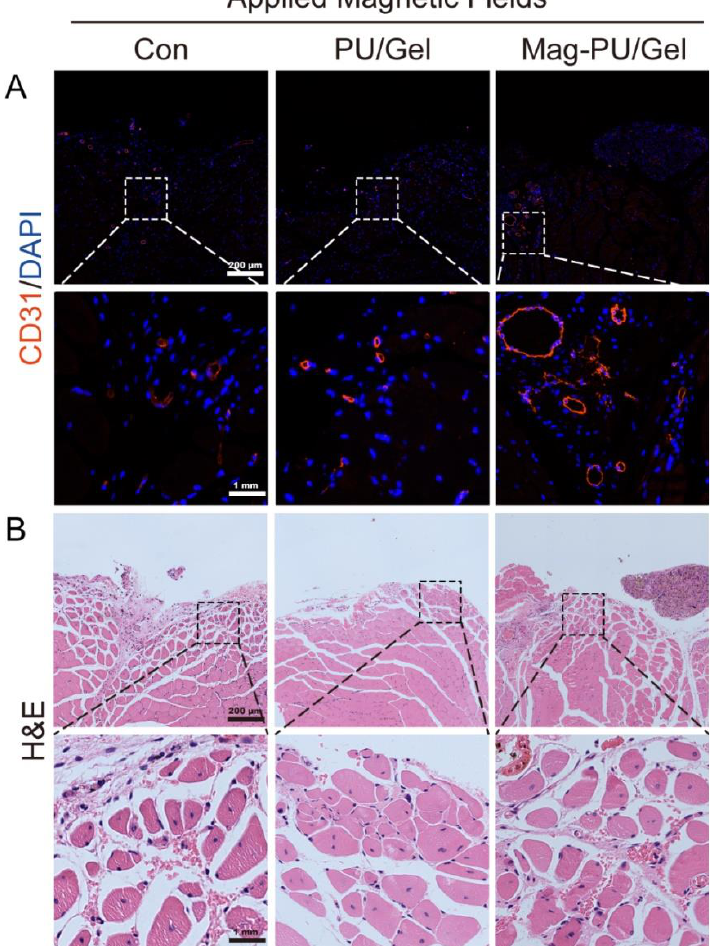
Figure 8. Effects of magnetic scaffolds combined with magnetic fields on tissue regeneration in situ after scaffold implantation. ( A ) Immunological fluorescent staining of CD31. ( B ) H&E staining of tissue in the defect area. The bottom panel in ( A , B ) shows magnified images within the dash- lined